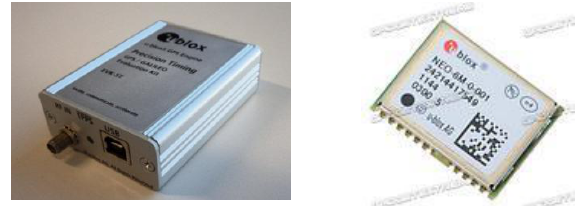
Figure 1. New generation of single frequency GNSS receiver (u-blox)